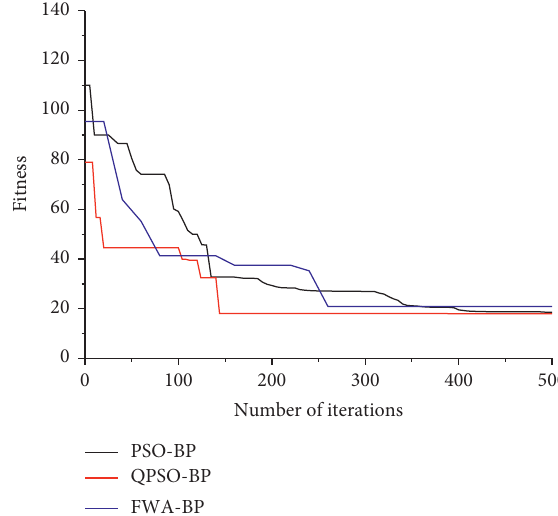
Figure 17: Convergence curves of the QPSO-BP, PSO-BP, and FWA-BP